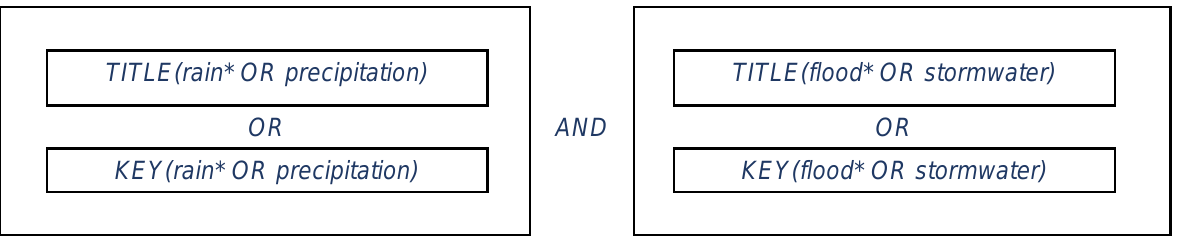
Figure 3. Search string to delimit the research field.